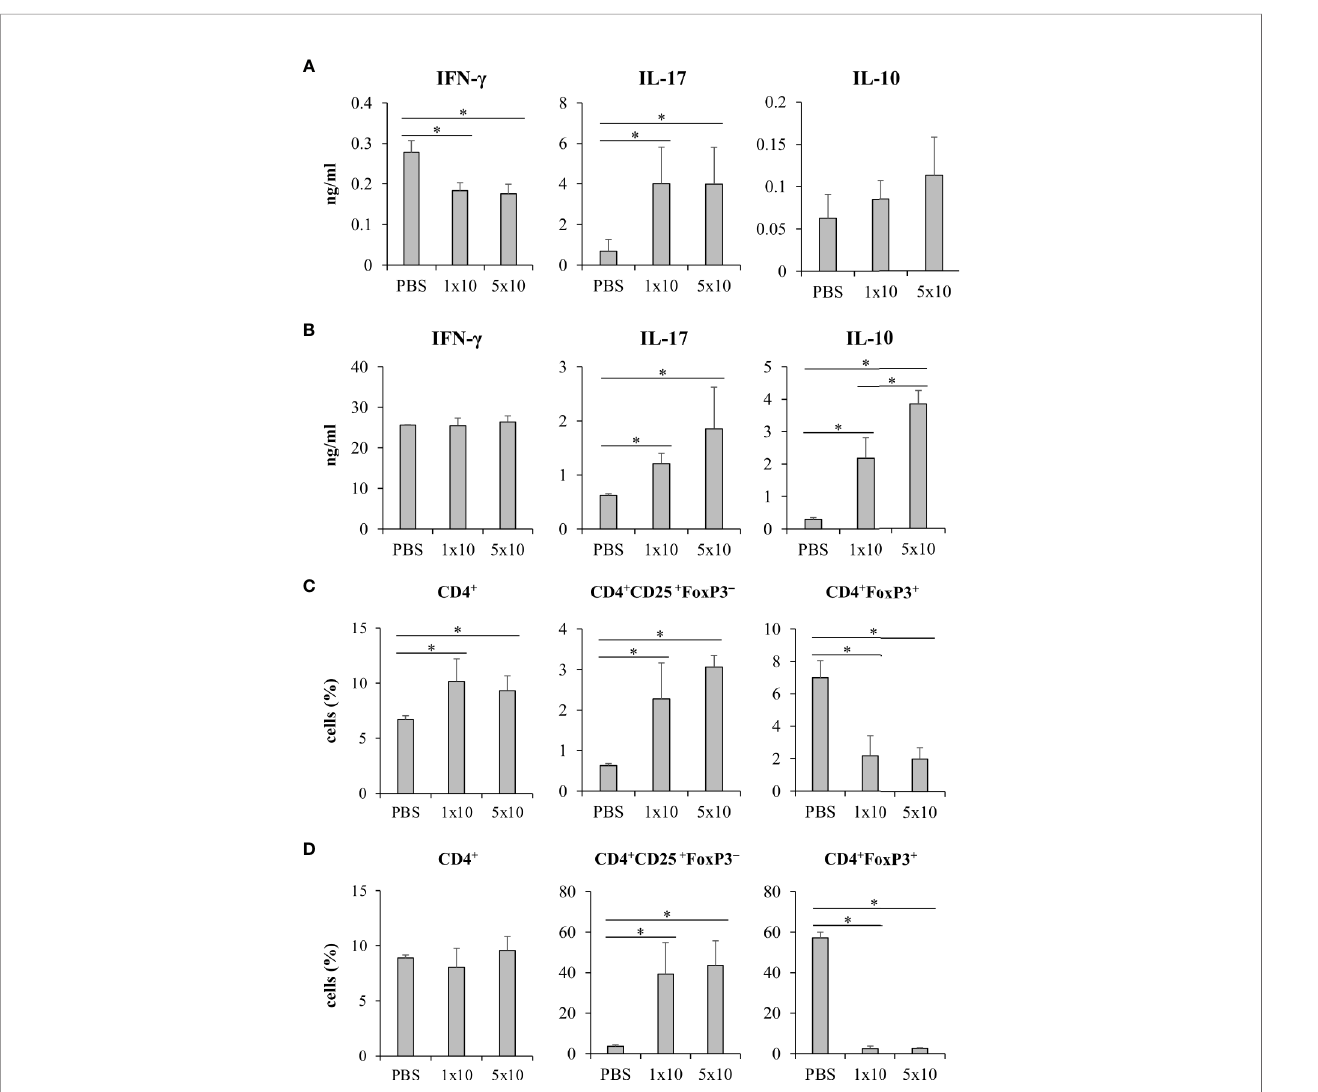
FIGURE 8 | Systemic C. krusei infection promoted IL-10 production. Mice were treated with dexamethasone to induce immunosuppression and were systemically infected with 1x10 6 and 5x10 6 of C. krusei . Serum and spleens were collected on day 7 post-infection. Splenocytes were re-stimulated with immobilized anti-CD3 for 48 h. (A) Serum cytokines. (B) Cytokines from supernatant from anti-CD3-stimulated splenocytes. (C) T cells from unstimulated splenocytes. (D) T cells from anti- CD3 stimulated splenocytes. n = 5. * p <